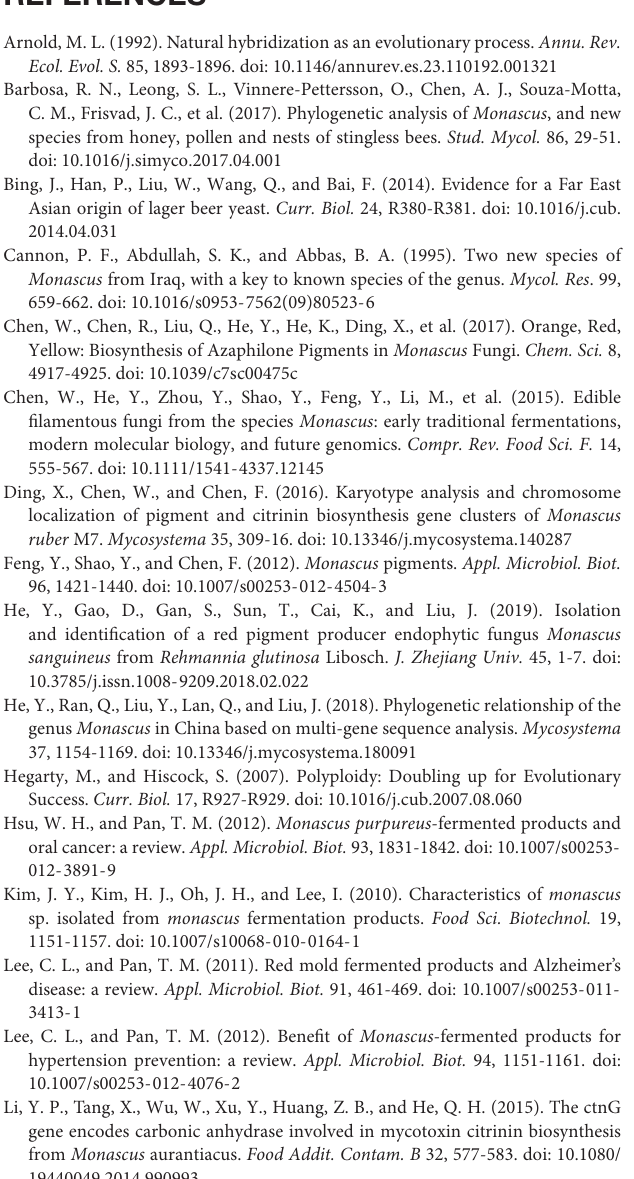
Supplementary Figure 1 | Single gene phylogenetic trees of the ITS, LSU, BenA , CaM , RPB2 , pksKS , and MAT1-1 gene regions of species from Monascus .